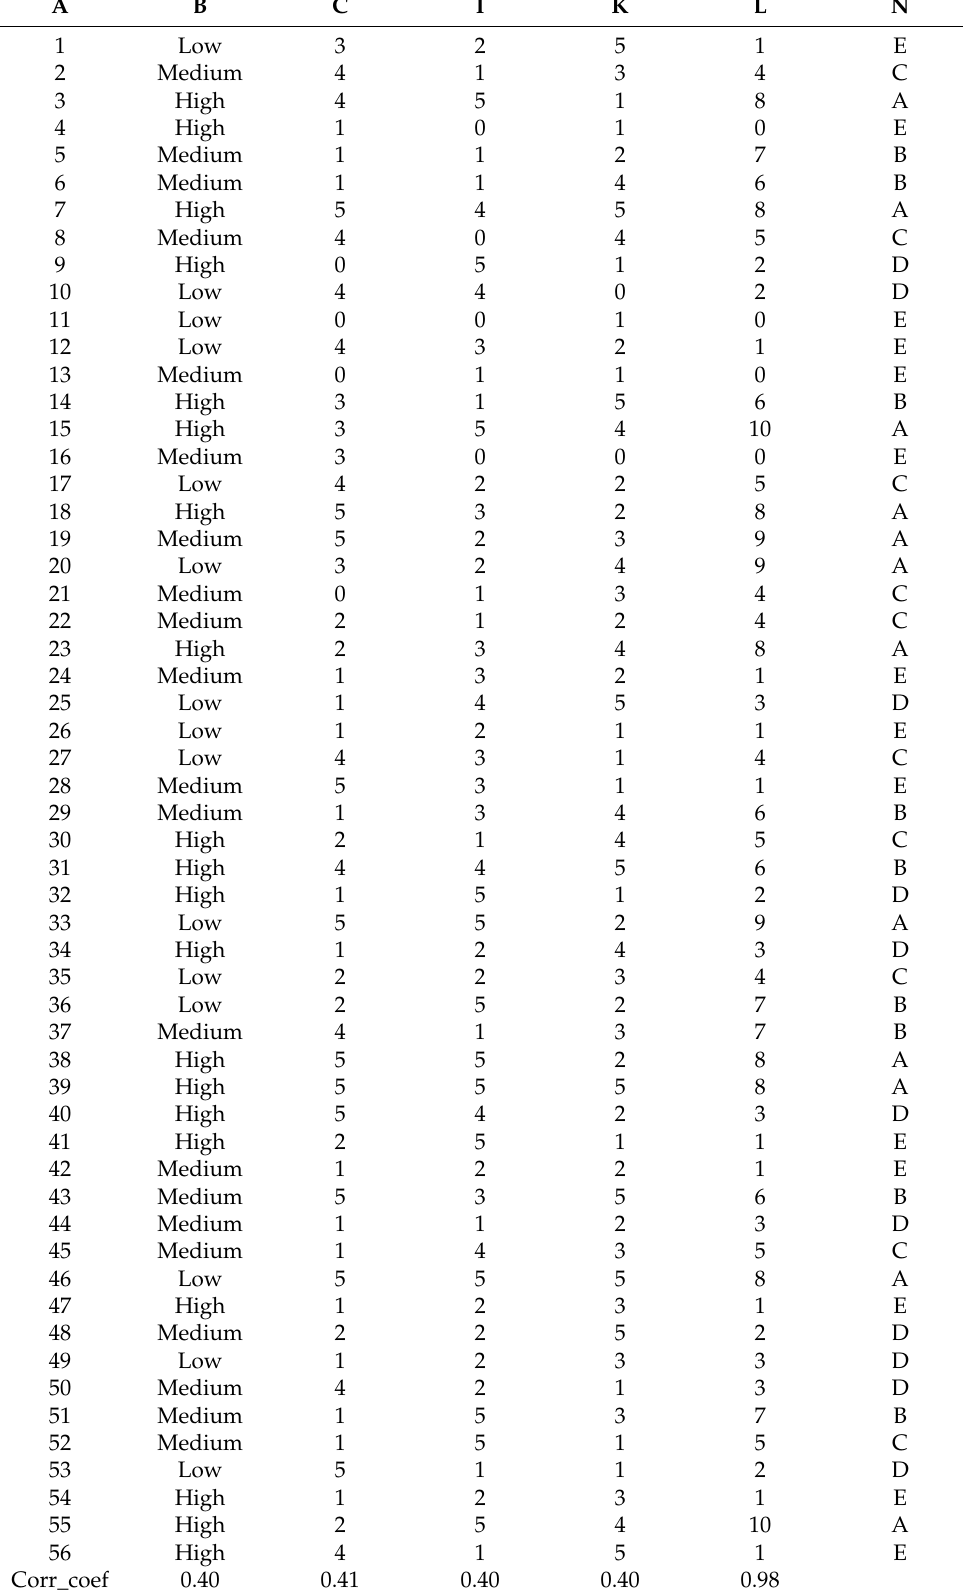
Table 3. Database for the generation of the .arff file with the factors that have the greatest impact on academic